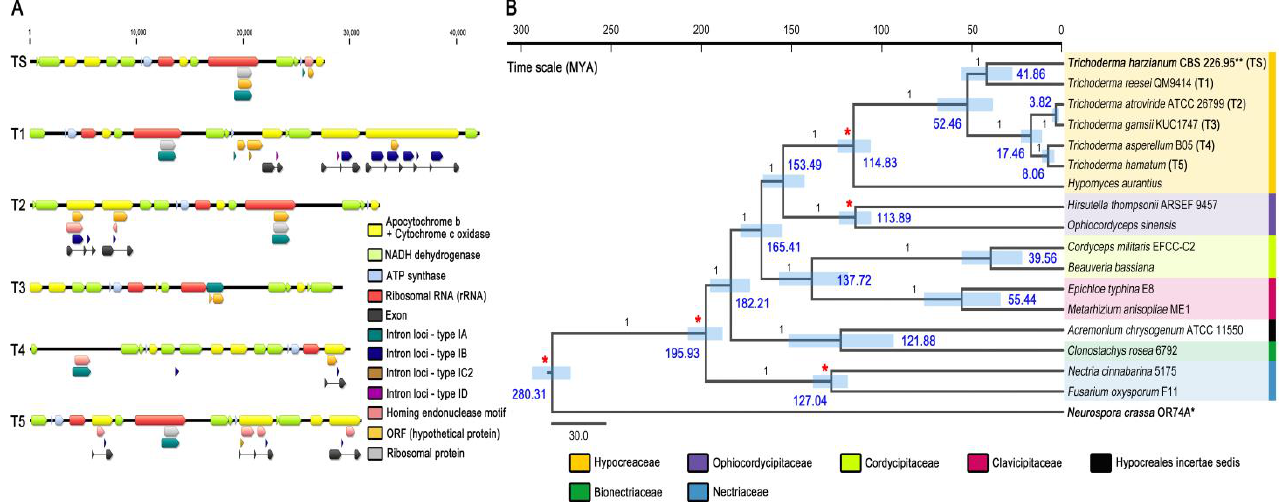
Figure 3. Comparative analysis of Trichoderma mitogenomes — I. ( A ) Comparison of the gene components. TS , T. harzianum CBS 226.95; T1 , T. reesei QM9414; T2 , T. atroviride ATCC 26799; T3 , T. gamsii KUC1747; T4 , T. asperellum B05; T5 , T. hamatum . ( B ) Bayesian chronogram for the evolutionary divergences of Trichoderma mitogenomes. Estimated chronological times were presented in the time scale of Mya (million years ago), with 95% confidence interval values in blue bars. Bayesian posterior probabilities (BPPs) values and calibration points were indicated at nodes using numbers (black) and asterisks (red), respectively. Asterisks for the Neurospora crassa OR74A mitogenome (*) and T. harzianum CBS 226.95 mitogenome (**).